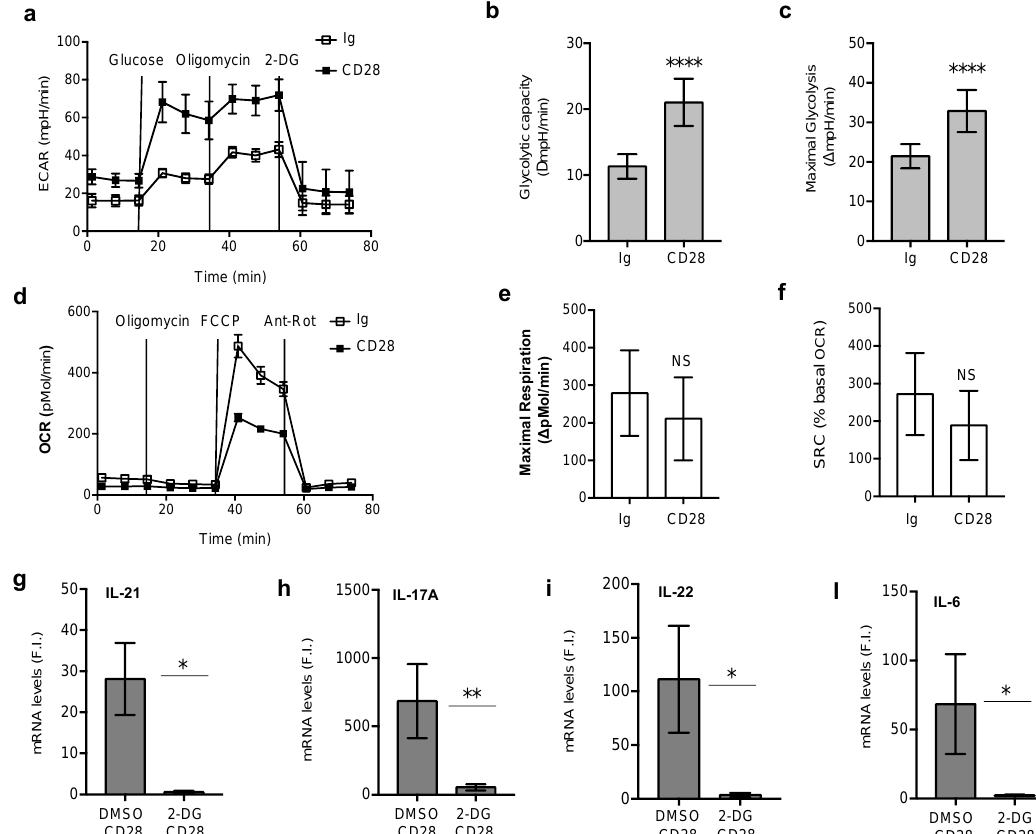
Figure 2. CD28 inflammatory functions in CD4 + T cells from relapsing-remitting multiple sclerosis (RRMS) patients depends on glycolysis. ( a ) Peripheral blood CD4 + T cells from a representative RRMS patient were activated for 18 h with 2 µ g mL − 1 isotype control Ig or anti-CD28.2 Abs. The kinetic profile of ECAR was measured at basal levels and following the addition of glucose, oligomycin or 2-DG. Data express the mean ± SEM of sextuplicate cultures. ( b,c ) CD4 + T cells from RRMS ( n = 17) were stimulated as in ( a ) and glycolytic capacity ( b ) and maximal glycolysis ( c ) were calculated from the ECAR profiles. Data express the mean ± SEM. ( d ) Peripheral blood CD4 + T cells from a representative RRMS patient were activated as in ( a ) and OCR was measured at basal levels and following the addition of oligomycin, FCCP or antimycin A and rotenone (Ant-Rot). Data express the mean ± SEM of sextuplicate cultures. ( e,f ) CD4 + T cells from RRMS ( n = 3) were activated as in ( a ) and maximal respiration ( e ) and SRC ( f ) were calculated from the OCR profiles. Data express the mean ± SEM. (****) p < 0.0001 by Wilcoxon test. NS = not significant. ( g–l ) CD4 + T cells from RRMS ( n = 10) cultured with DMSO, as control, or 100 µ M 2-DG were activated for 6 h ( g,l ) or 24 h ( h,i ) with 2 µ g mL − 1 isotype control Ig or anti-CD28.2 Abs and IL-21 ( g ), IL-17A ( h ), IL-22 ( i ) and IL-6 ( l ) mRNA levels were analyzed by real time PCR. The values expressed as fold inductions (F.I.) over isotype control Ig-stimulated cells after normalization to GAPDH ( e ). Bars represent the mean ± SEM and statistical significance was calculated by an unpaired Student’s t test. (*) p < 0.05, (**) p < 0.01.